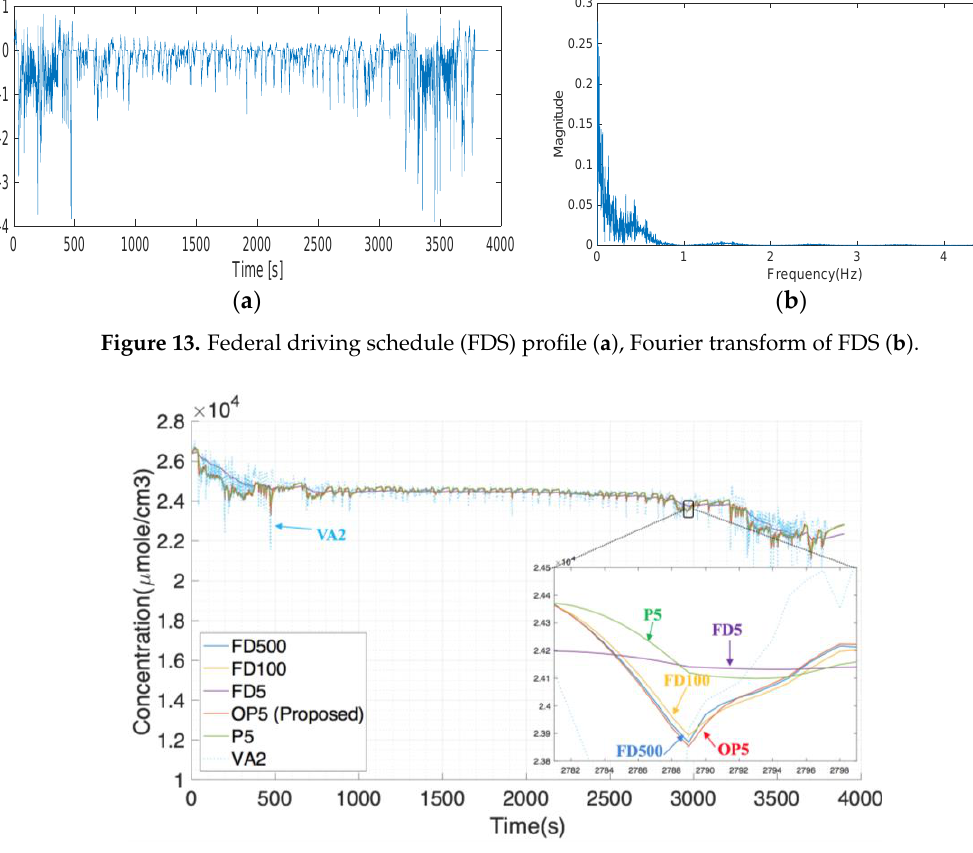
Figure 14. Time-domain simulation of different algorithms based on FDS.